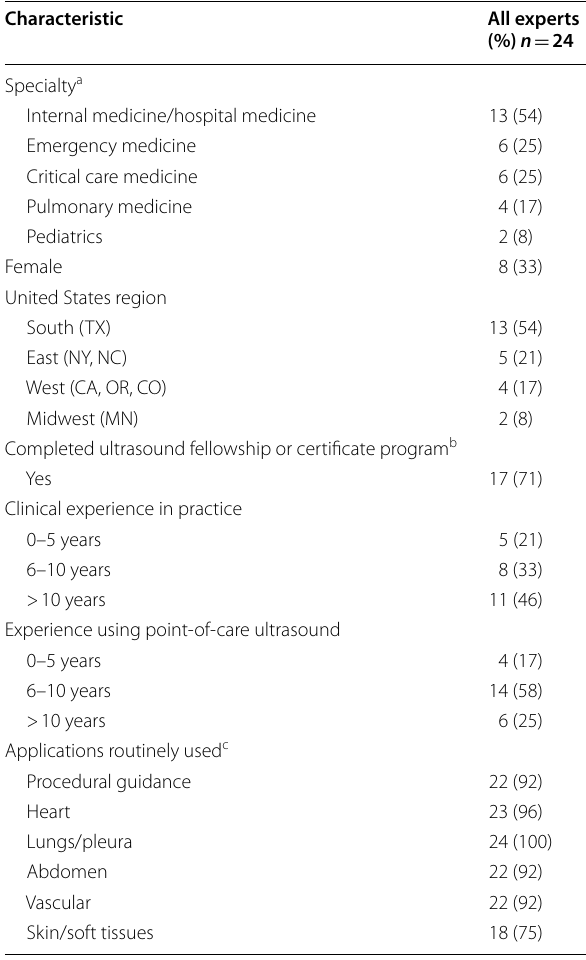
Table 1 Characteristics of the point‑of‑care ultrasound expert